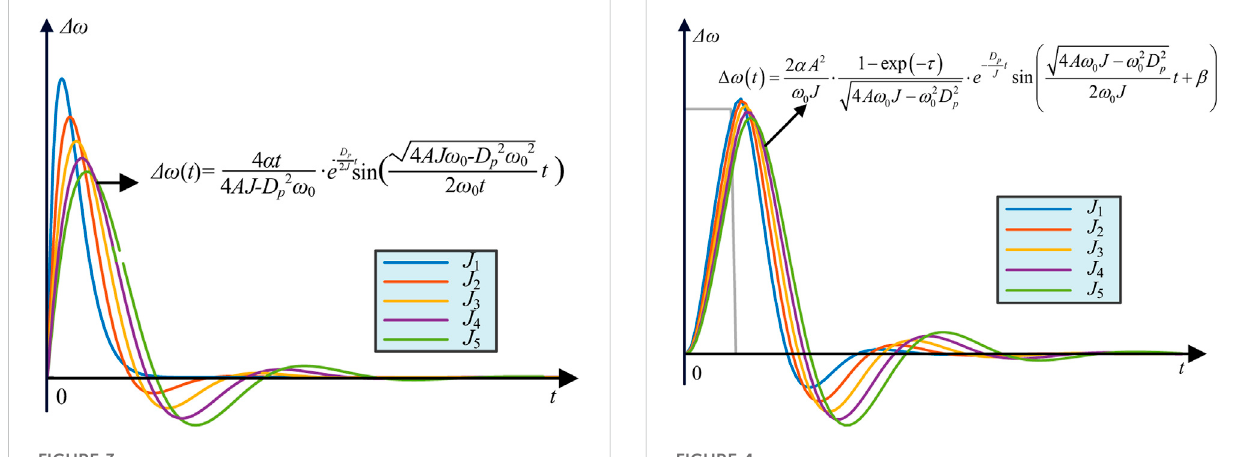
FIGURE 4 Frequency response under different virtual inertia values in the short time drop of the grid